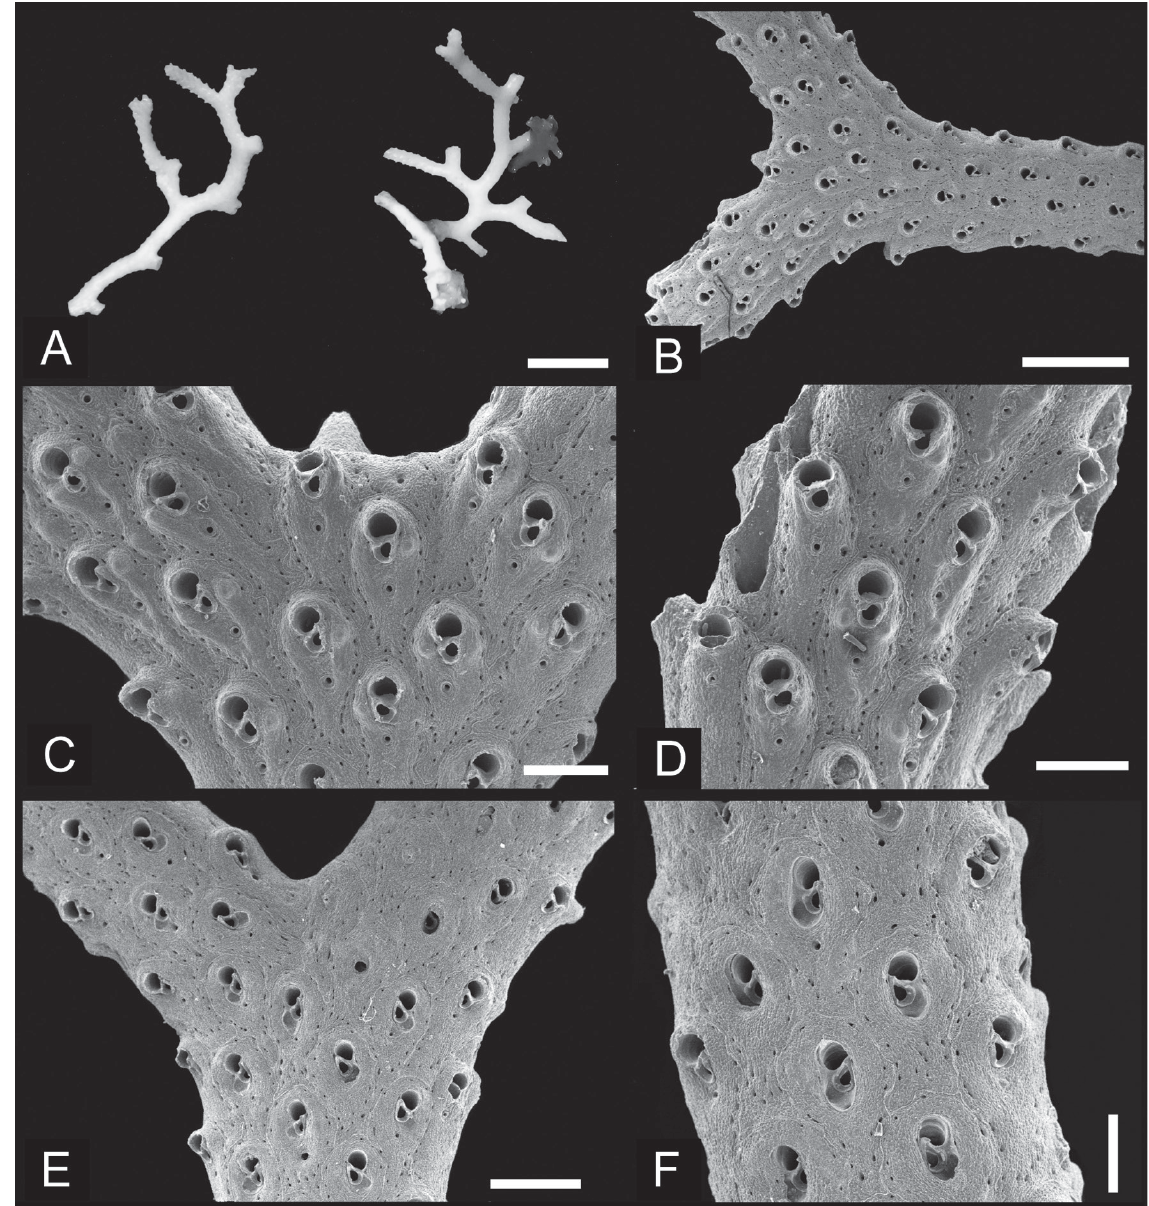
Fig. 6. Adeonellopsis arculifera (Canu & Bassler, 1929) . A . Colonies collected sW of Yakushima island (NsMT-Te789). B . Branch showing crenulate periphery (NsMT-Te781). C . enlargement of bifurcation showing autozooids with oblique avicularium and single small spiramen (NsMT-Te781). D . Young autozooids showing peristomial rim and single small spiramen (NsMT-Te781). E . old part of branch, showing various stages in formation of kenozooids (NsMT-Te781). F . old part of branch, showing autozooids with depression containing avicularium and spiramen (NsMT-Te781). A = optical photograph; B–F = SEM images. Scale bars: A = 5 mm; B = 1 mm; C–D = 300 μm; E = 500 μm; F = 250